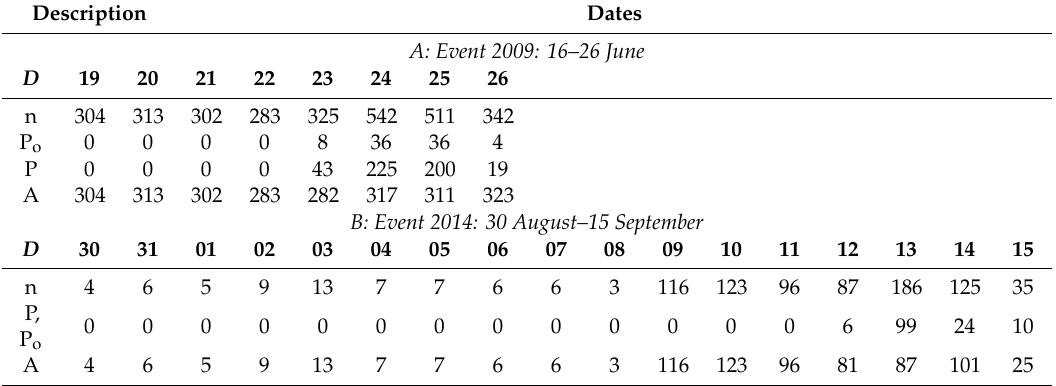
Table A3. Temporal distribution of landslide presence and absence